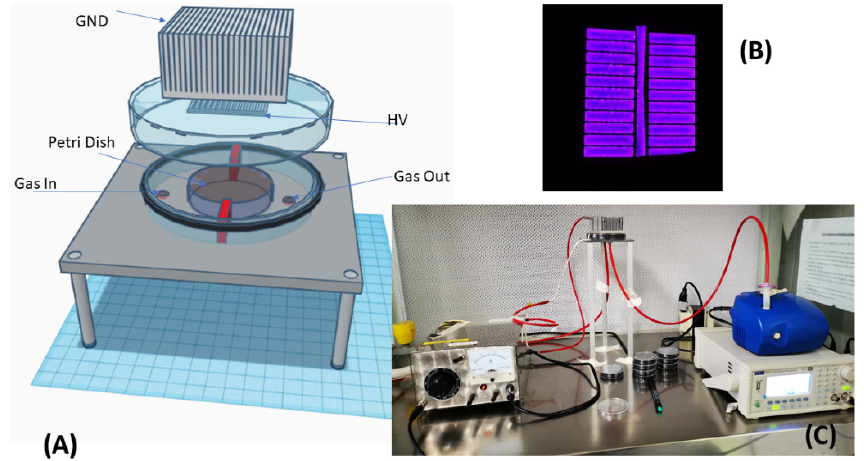
Figure 1. Experimental setup: ( A ) SDBD discharge reactor; ( B ) plasma produced on SDBD Surface in the air; ( C ) setup under a laminar flow hood.